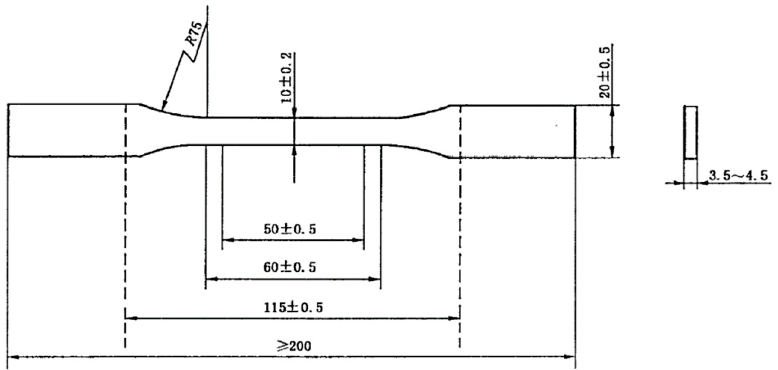
Figure 2. Tensile sample (unit: mm).